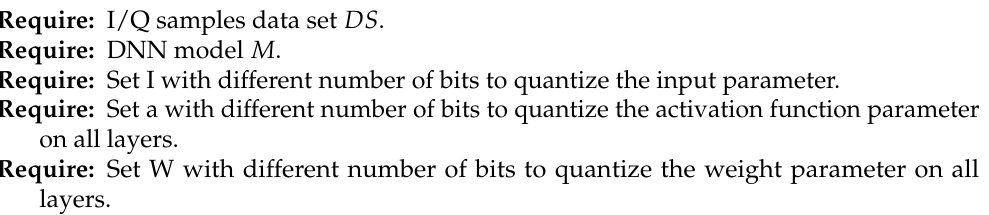
Algorithm 1 Screening: Detection of relevant